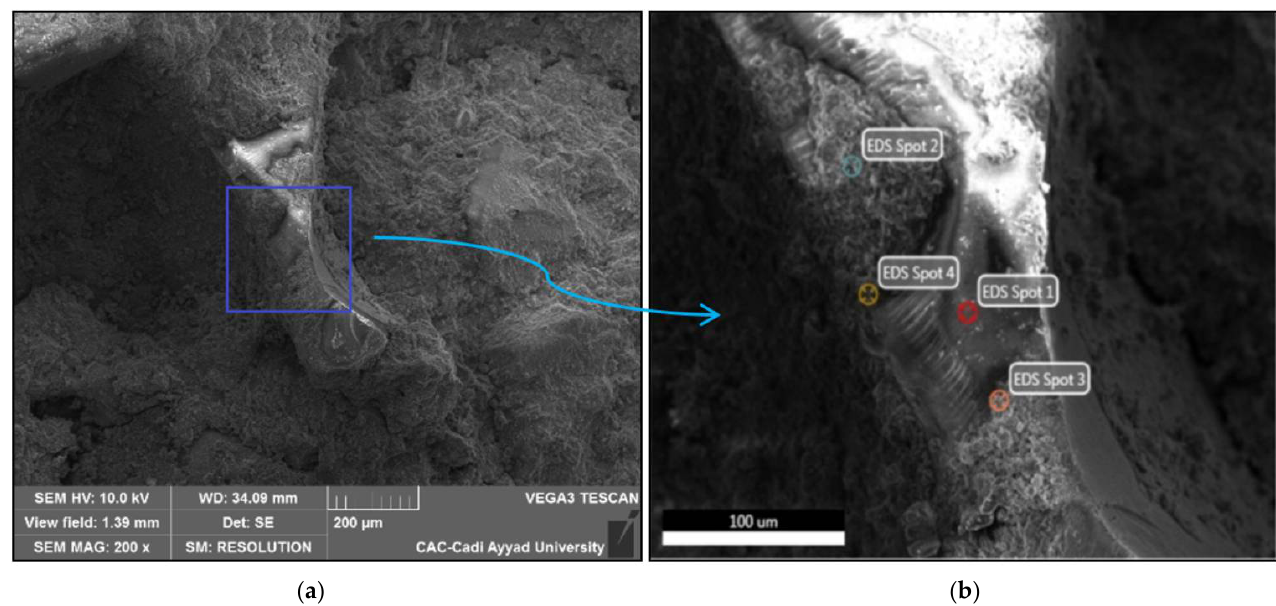
Figure 8. SEM-EDS micrographs of MRWG50: ( a ) SEM picture at length scale 200 μm and ( b ) Spots of EDS imaging.